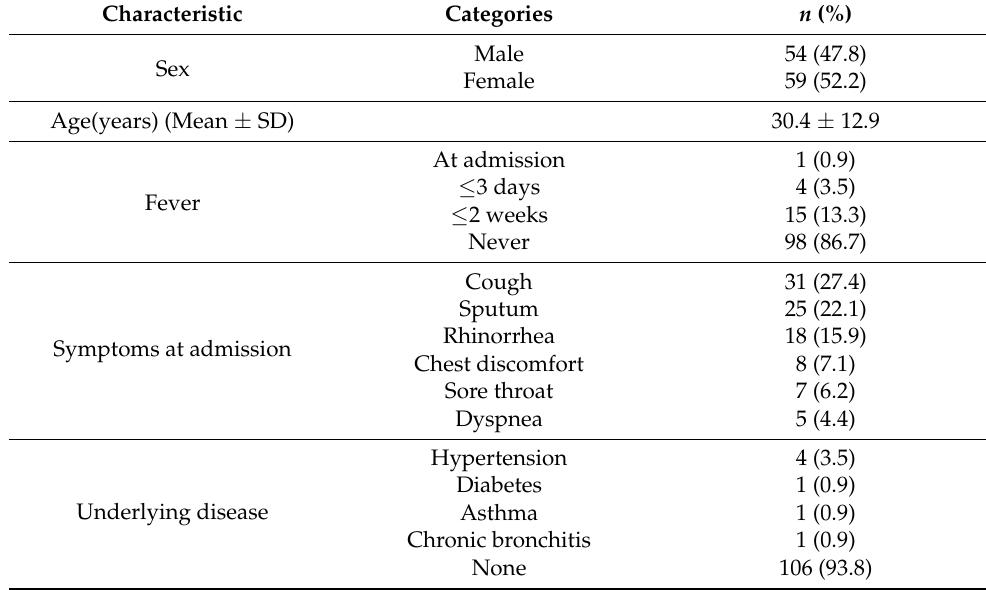
Table 4. Patients’ general characteristics ( N = 69).